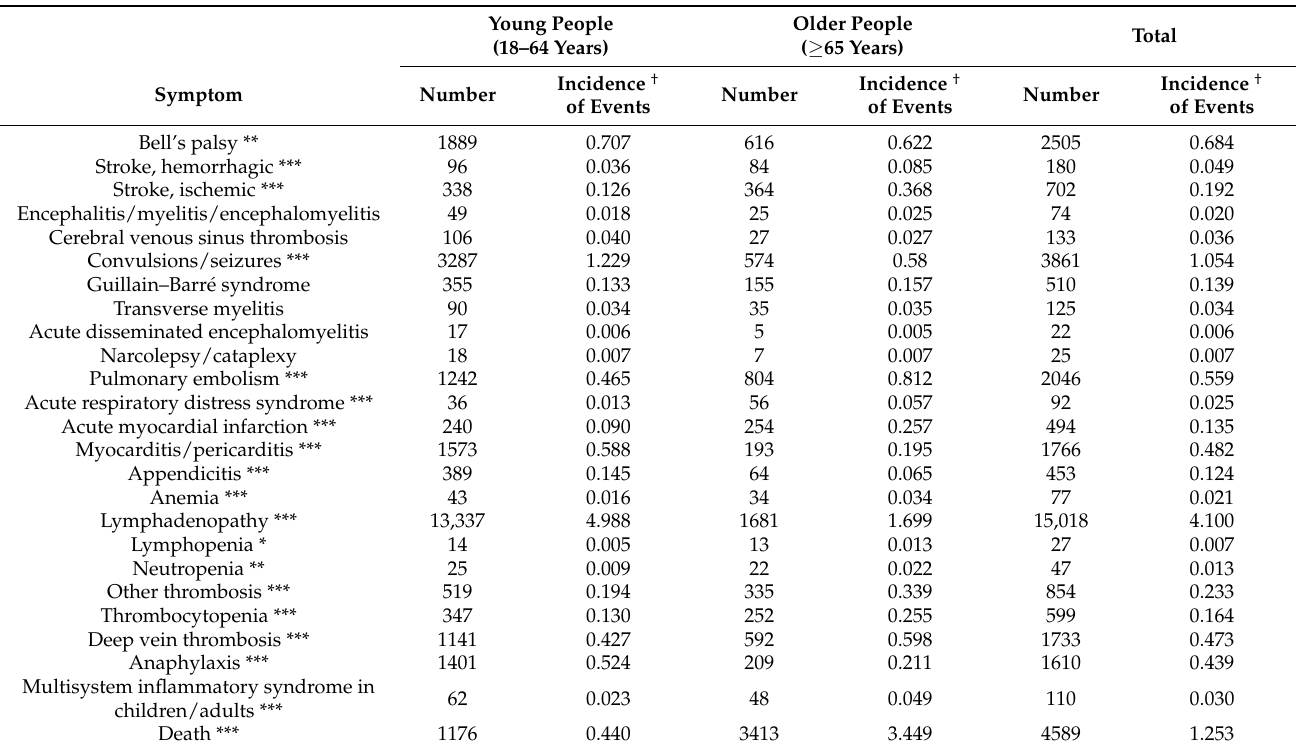
Table 3. Incidence (per 100,000 people) of 25 severe AEs between young (18–64 years) and older people ( ≥ 65 years) after